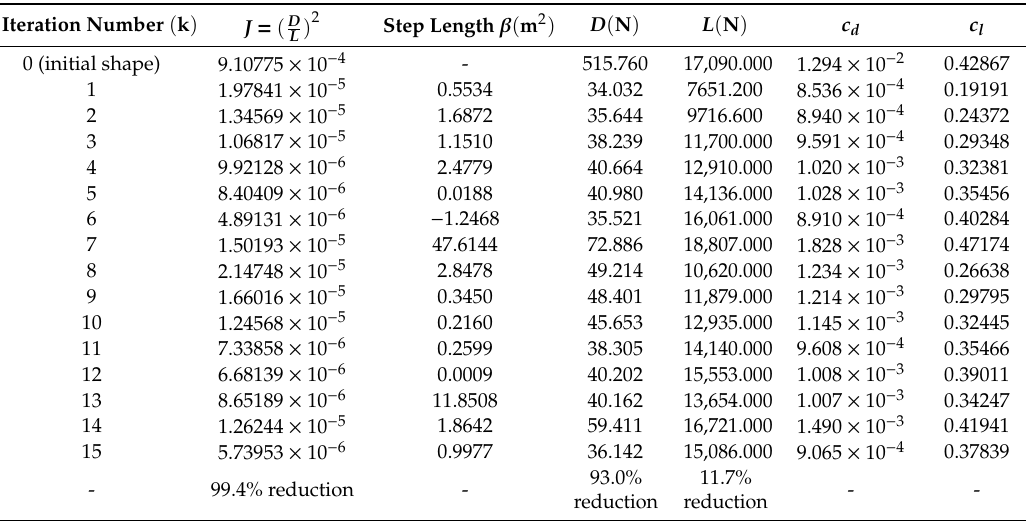
Table 1. Results for the test